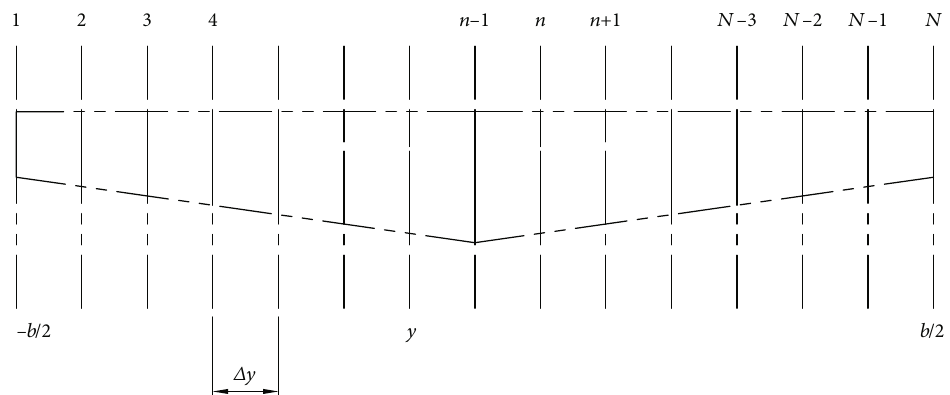
Figure 1: The positions of the